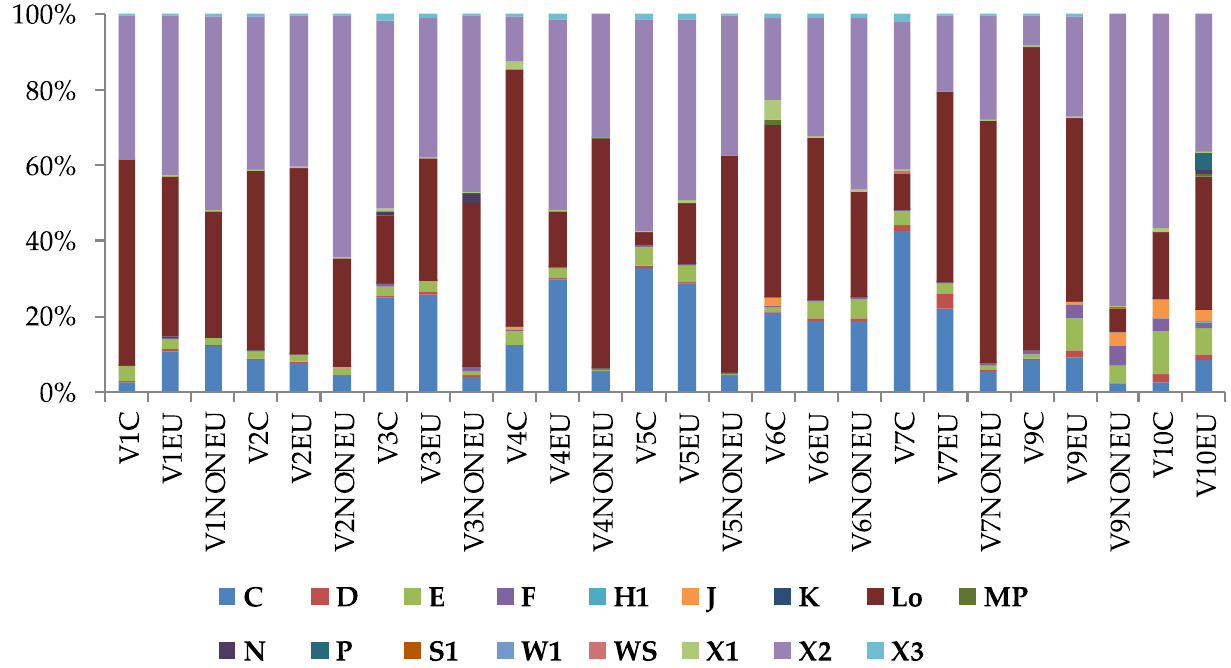
Figure 4. Relative biomass shares of Reynolds’ functional groups (expressed in percentages) in the composite (C), euphotic (EU) and aphotic (NONEU) zone samples from the sampling stations (V1 to V10, excluding station V8) in Lake Visovac during August 2018 according to the morphological approach.